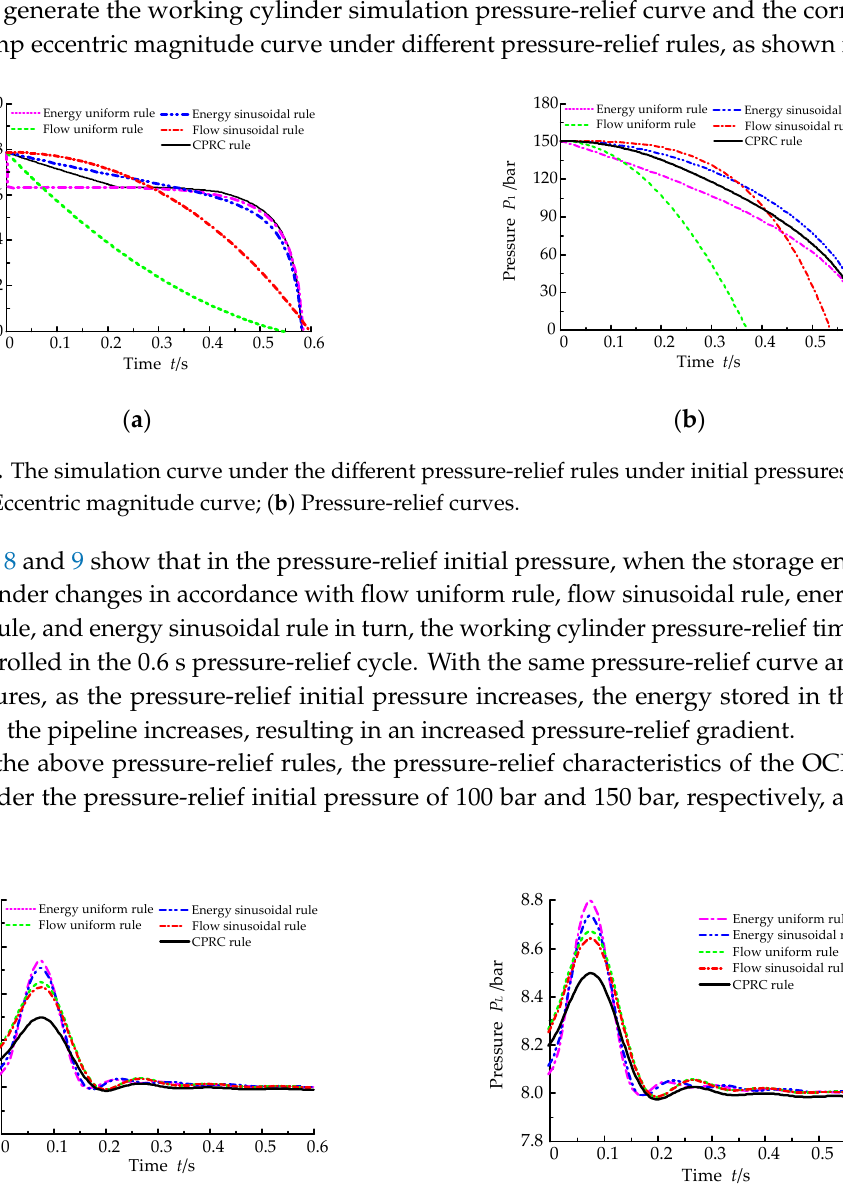
Figure 10. The pressure response curve of the pressure-relief pipe under initial pressures of 100 bar and 150 bar. ( a ) 100 bar initial pressure; ( b ) 150 bar initial pressure.